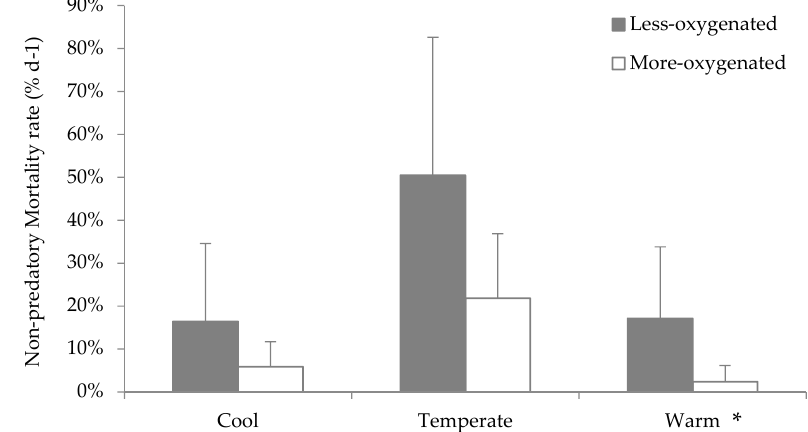
Figure 12. The average daily non-predatory mortality (% d − 1 ) of the copepod Acartia tonsa between More-oxygenated (M) and Less-oxygenated (L) subgroups within temperature groups (Cool, Temp, Warm). Error bars indicate standard deviations, and * indicates a significant difference in a Kruskal-Wallis test at α = 0.05.